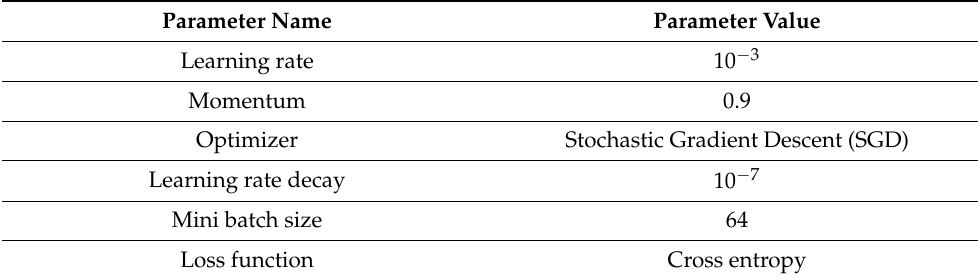
Table 1. Summary of hyperparameters for DCNN